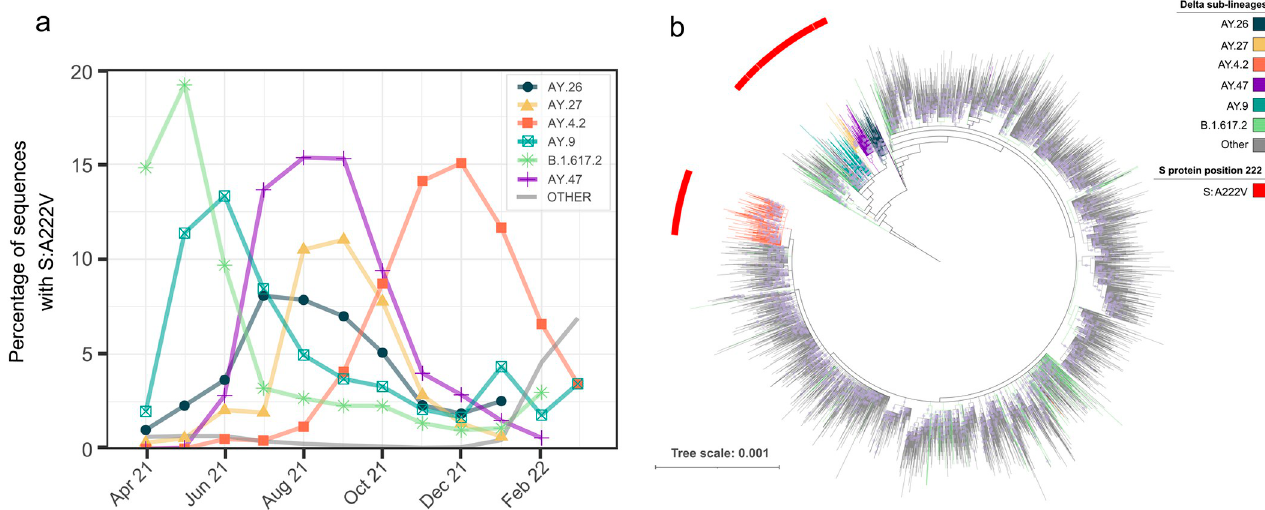
Fig 2. Temporal and phylogenetic distribution of the S:A222V in B.1.617.2 sequences. ( a) Percentage of sequences designated as parental B.1.617.2 and its sub-lineages (designated as AY) with S:A222V by month. ( b) Maximum likelihood phylogeny of 10,049 sequences from Lineages B.1.617.2 and derivatives. Phylogeny rooted with reference MN908947.3. Red external ring indicates sequences with S:A222V, the colour of branches indicates B.1.617.2 sub-lineages of interest. The scale bar indicates the number of nucleotide substitutions per site. Each circle in branches correlates with the bootstrap value; only bootstraps from 70 to 100 are